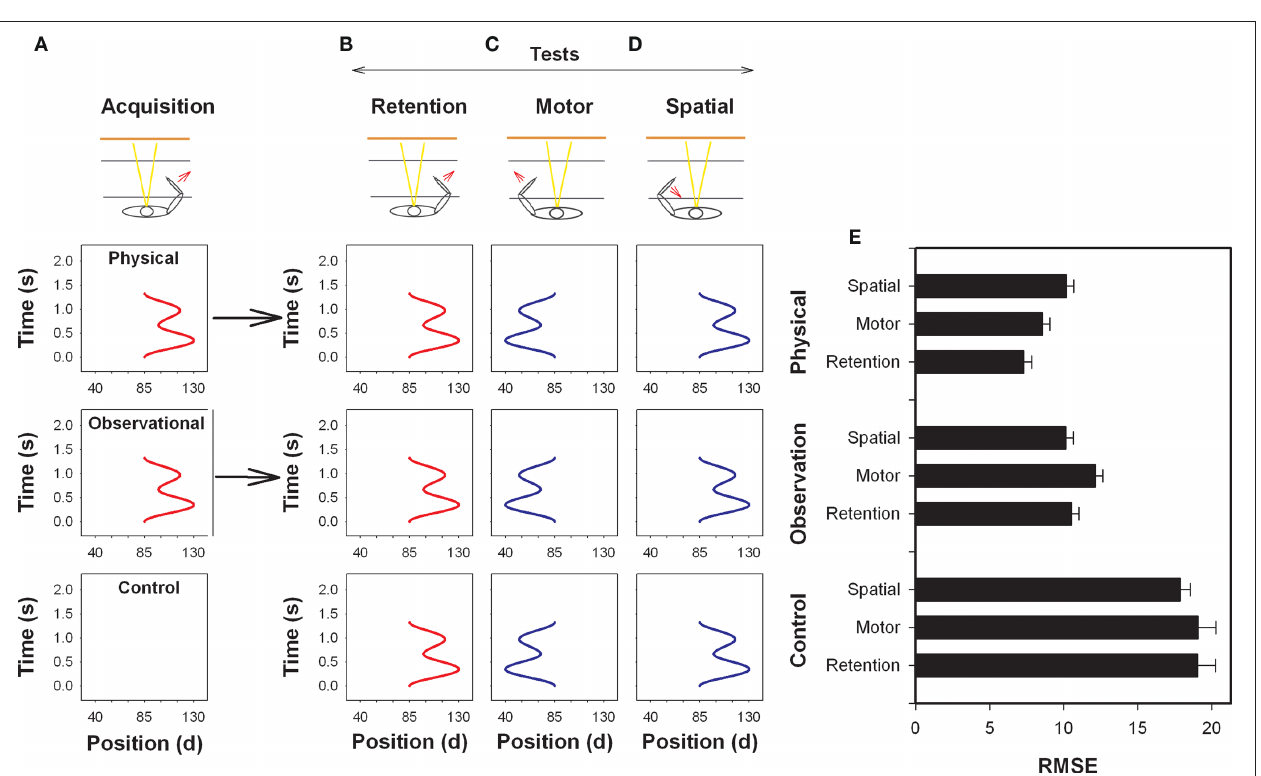
Figure 5 | illustration of the arm used during acquisition (A) and on the retention (B), motor (C) and spatial (D) tests. The arm used and direction of movement is indicated by an arrow (bottom) and the goal movements (top) are